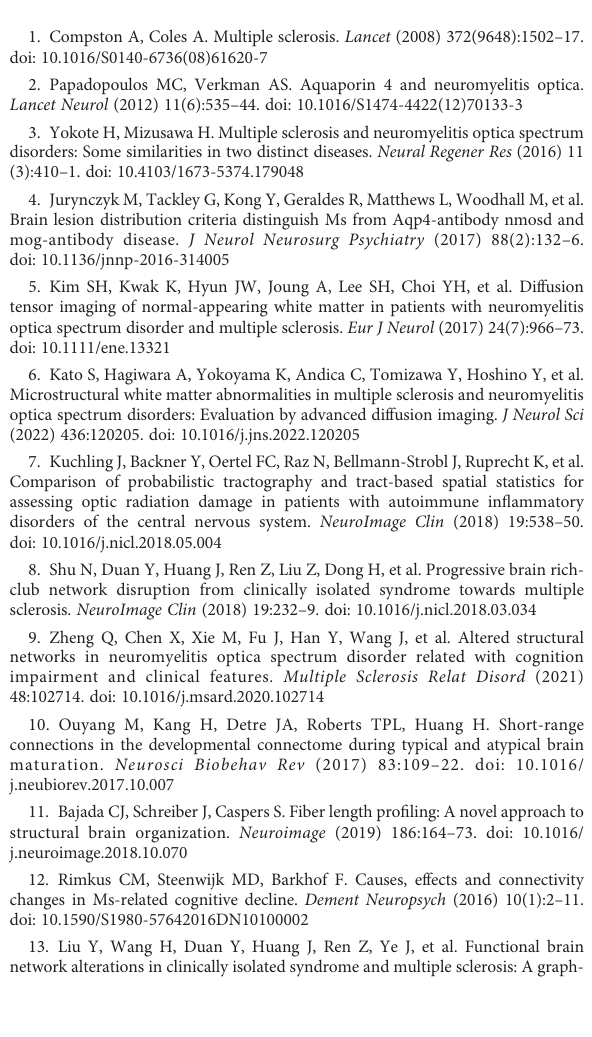
SUPPLEMENTARY FIGURE 1 The distribution of short-, middle-, and long-range connection in HC, RRMS and NMOSD patients. SUPPLEMENTARY FIGURE 2 The relationships about FN and FA of short-, middle- and long-range connection in patients with RRMS and NMOSD. FN, fi ber number; FA, fractional